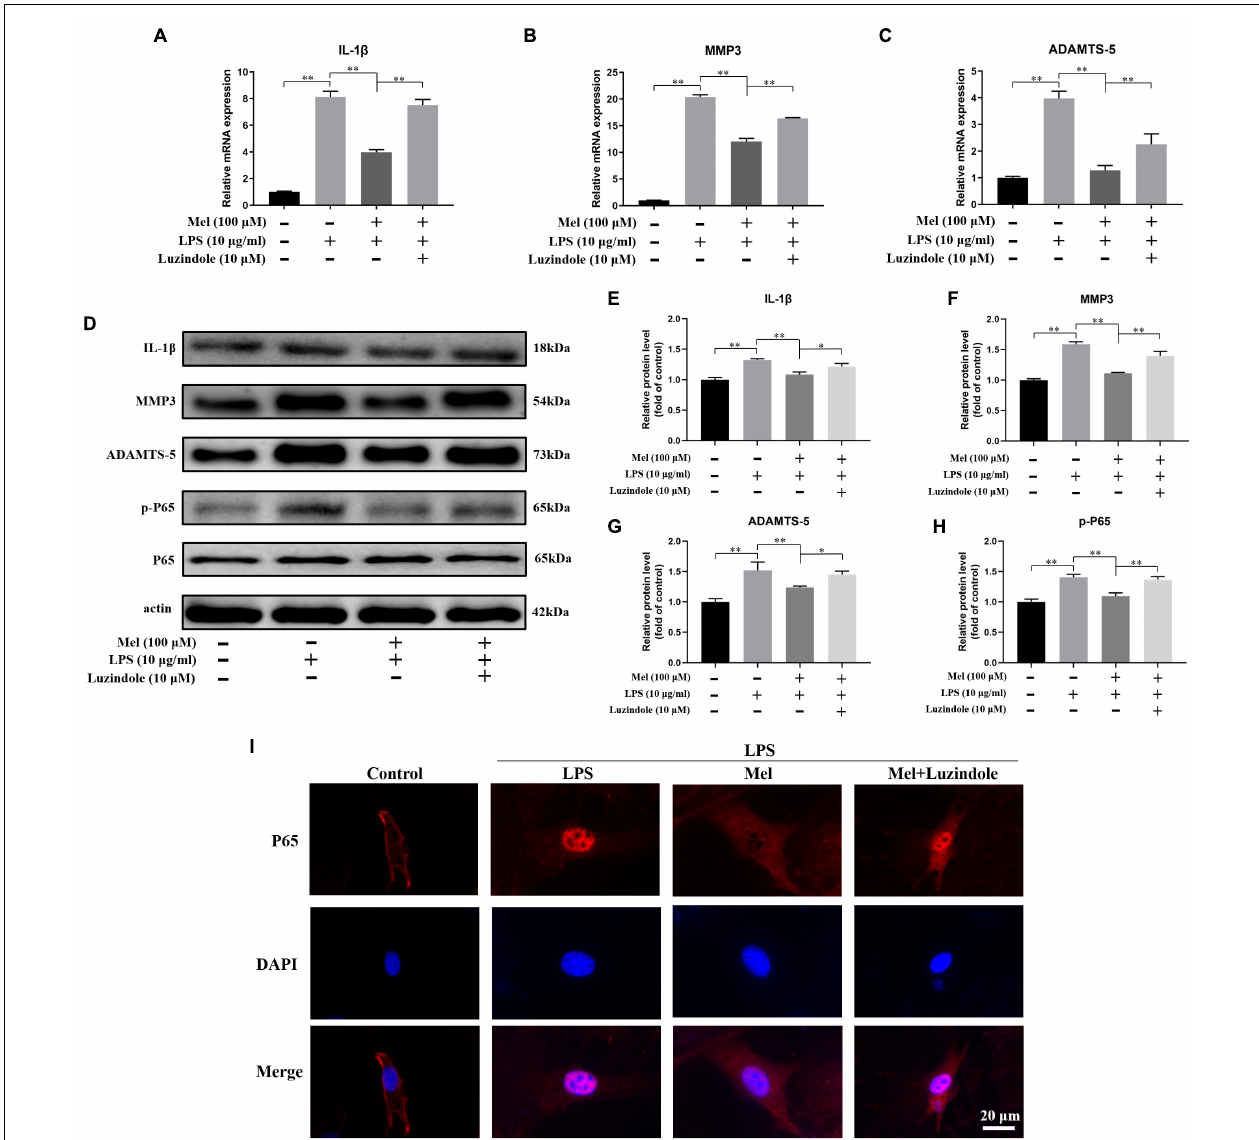
FIGURE 7 | Melatonin (Mel) alleviated the degeneration of endplate cartilaginous cells (EPCs) through inhibiting inflammatory response and matrix degradation activated by NF- κ B pathway. (A–C) qRT-PCR analysis of the relative mRNA expression of IL-1 β (A) , matrix metalloproteinase-3 (MMP3) (B) , and ADAMTS-5 (C) under lipopolysaccharide (LPS), Mel, and Luzindole treatment. (D) Western blotting for proteins of IL-1 β , MMP3, ADAMTS-5, p-P65, and P65 under LPS, Mel, and Luzindole treatment. (E–H) Quantitation of relative protein level of IL-1 β , MMP3, ADAMTS-5, and p-P65. (I) Immunofluorescence staining of P65 nuclear translocation under LPS, Mel, and Luzindole treatment ( ∗ P < 0.05, ∗∗ P <